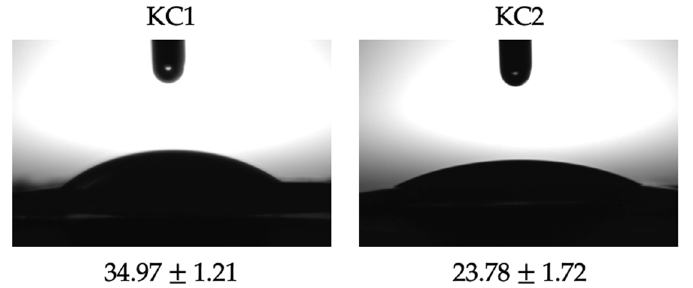
Figure 1. Contact angle for KC1 and KC2 particles produced by the solid dispersion